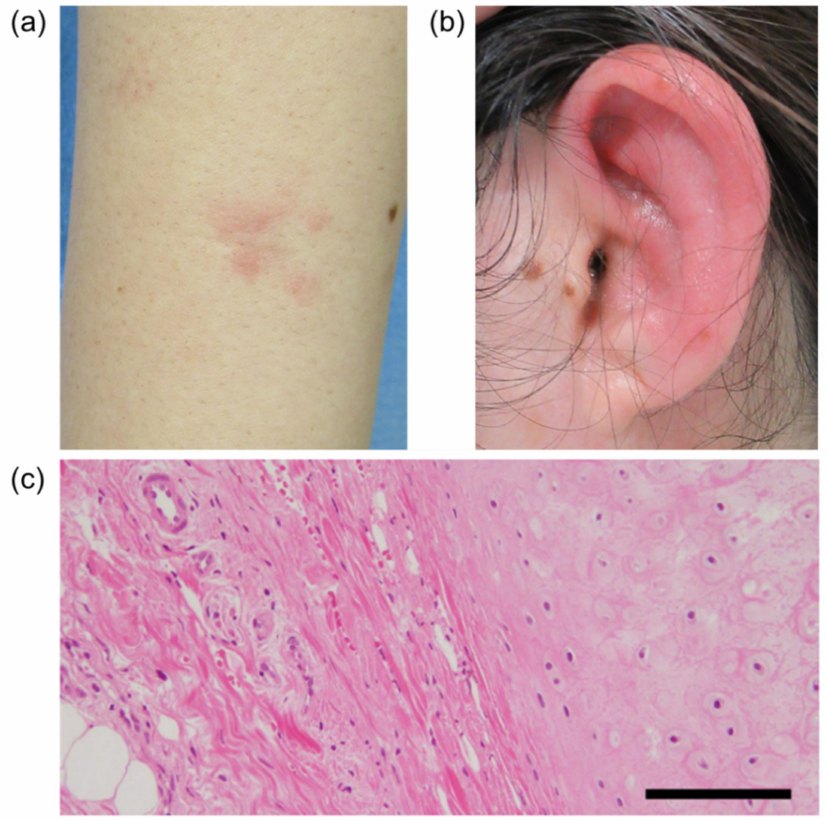
Figure 1. The patient’s right forearm ( a ) and left ear ( b ). ( c ) Pathological findings for the auricular